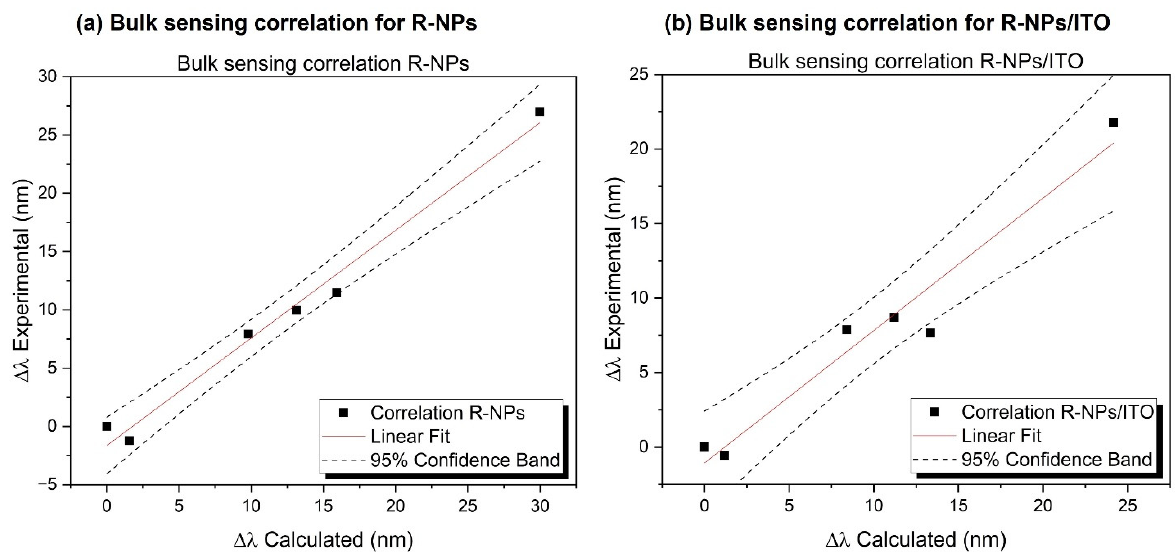
Figure 3. Bulk sensing correlation between experimental and calculated shift for ( a ) R-NPs and ( b ) ( b ) R-NPs/ITO.